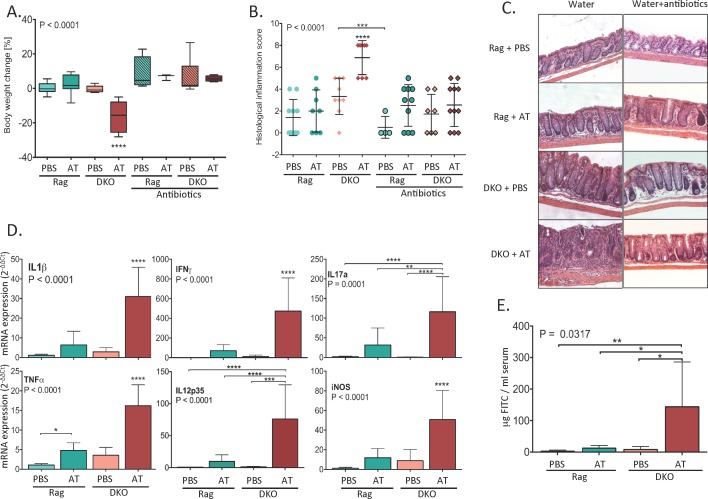
After adoptive T cell transfer, NHE3-/-Rag2-/- DKO mice develop severe colitis, which is alleviated by broad-spectrum antibiotic treatment.(A) Changes in body weight (% change of initial value 13 days post-transfer; boxes extend from 25th to 75th percentiles of values, whiskers represent min and max value, line within the box represents the mean value); (B) Histological colitis scoring (dots represent individual mice and lines mean value ± SD); (C) Representative H&E images of distal colon from respective experimental groups; (D) qPCR analysis of mucosal expression of proinflammatory cytokines in Rag/PBS (N = 10), Rag/AT (N = 8) and DKO/PBS (N = 9) and DKO/AT (N = 8) mice (bar graphs represent mean ± SD values); (E) Intestinal mucosal permeability measured by FITC-labeled dextran tracer flux (N = 3–6). Statistical analysis was performed using one-way ANOVA (ANOVA P value is indicated in each panel) with Fisher’s LSD post-hoc test. Asterisks in all panels indicate statistical significance: * P < 0.05, ** P < 0.01, *** P< 0.001, **** P < 0.0001. Brackets point to differences between indicated groups. Asterisks without brackets indicate a statistical difference from all other groups within the panel. Each experimental groups is color coded in a way consistent in the remaining figures.